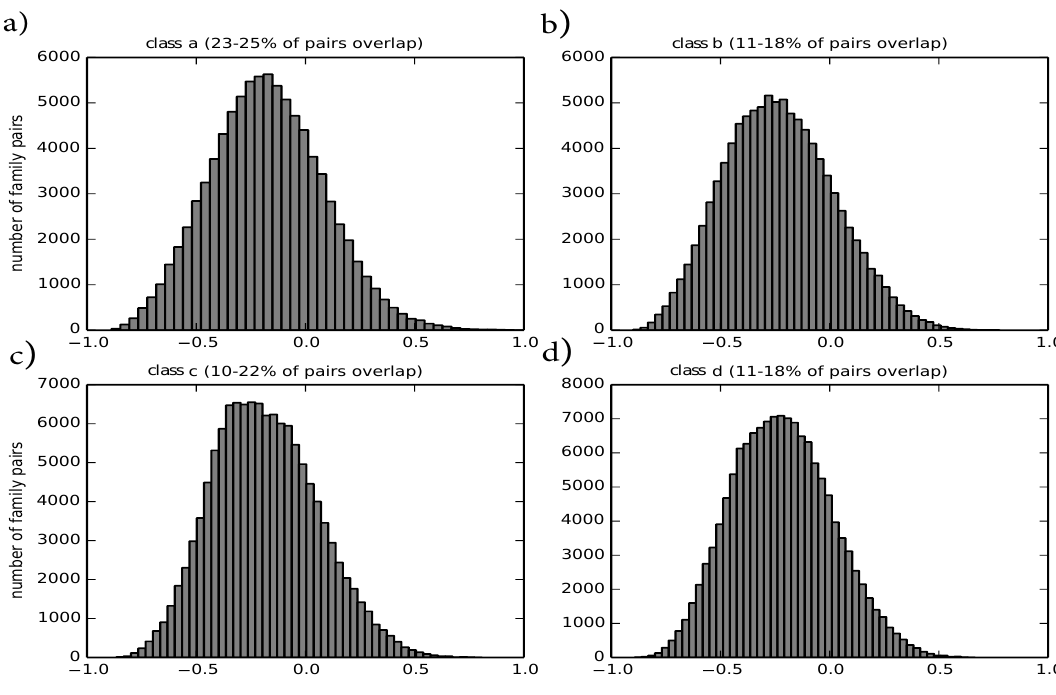
Figure 5. Histograms of overlap values between any two multi-member families for the four main classes a–d: ( a ) corresponds to class a; ( b ) corresponds to class b; ( c ) corresponds to class c; ( d ) corresponds to class d. The title gives an interval on the percentage of overlapping families, computed by using lower and upper bounds,